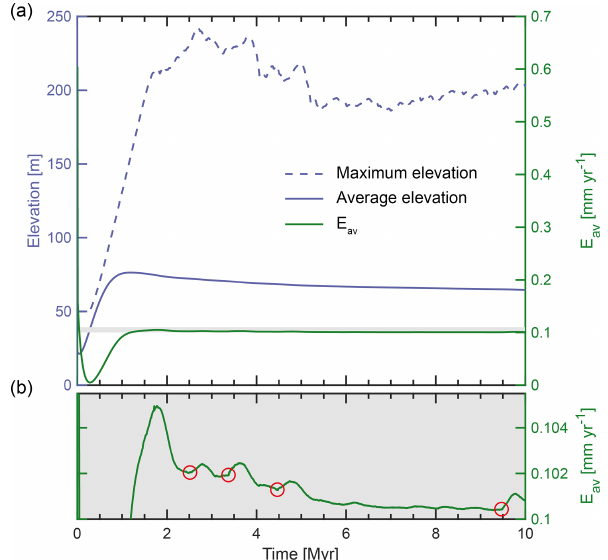
Figure 4. Evolution of the reference model over time. (a) Aver- age elevation (solid blue line), maximum elevation (dashed blue line) and average denudation rate (solid green line) over the whole model. (b) Expanded view of the mean denudation rate of (a) (in the light grey area). Red circles highlight significant stream cap- tures that lead to an abrupt increase in average denudation rates over a subsequent period of several time steps (effects associated with stream captures at 4.5 and 9.5Ma are visible in Fig. 3e and f,